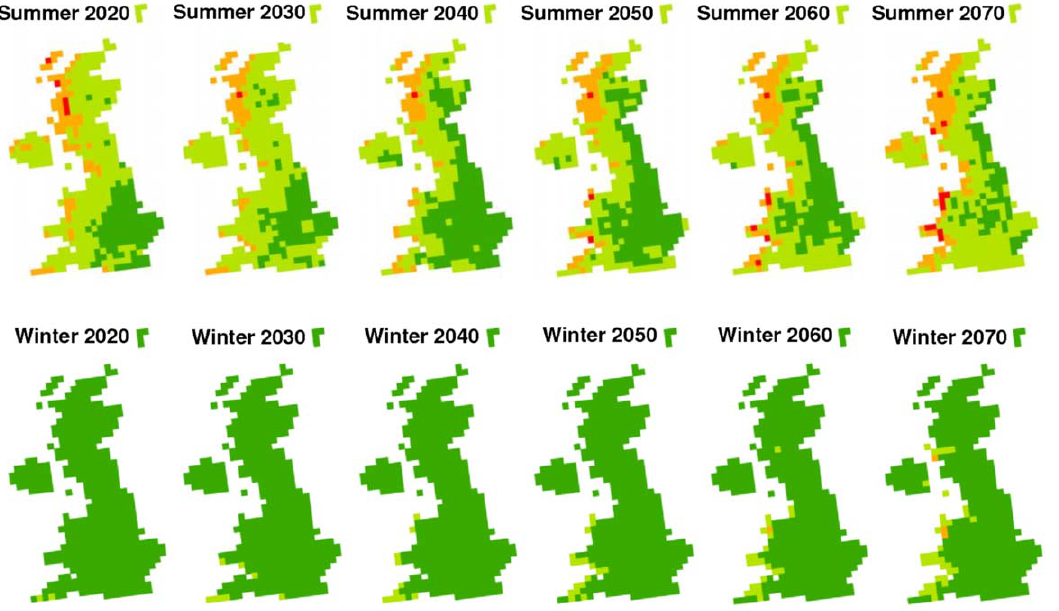
Figure 5. Projected change in fasciolosis risk. Summer and winter F. hepatica risk across the UK at a resolution of 25 km squares, 2020–2070. Risk categories are based on those used by Ollerenshaw & Rowlands [22]: Little or no disease: Mt , 300 (dark green), occasional losses: 300 , Mt =400 (light green), disease prevalent: 400 , Mt =474 (orange), serious epidemic: Mt . 474 (red).